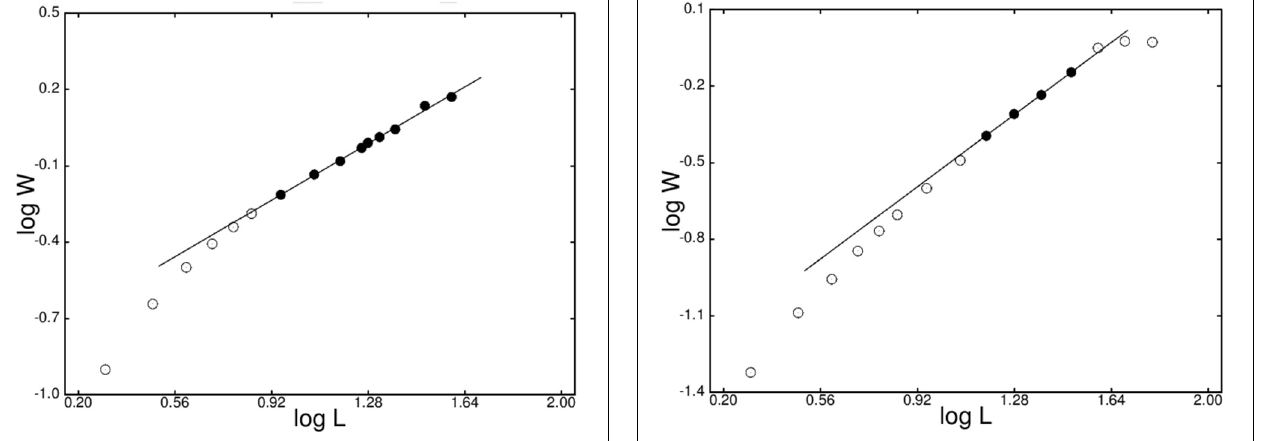
FIGURE 5 | Logarithmic plot, showing the roughness, W , as a function of the system size, L , for disorder D = 1. Black circles denote those points to which the straight line, with slope ζ = 0 . 77(1), has been fitted. The errors on the points are larger than the size of the points, except for the largest system L =